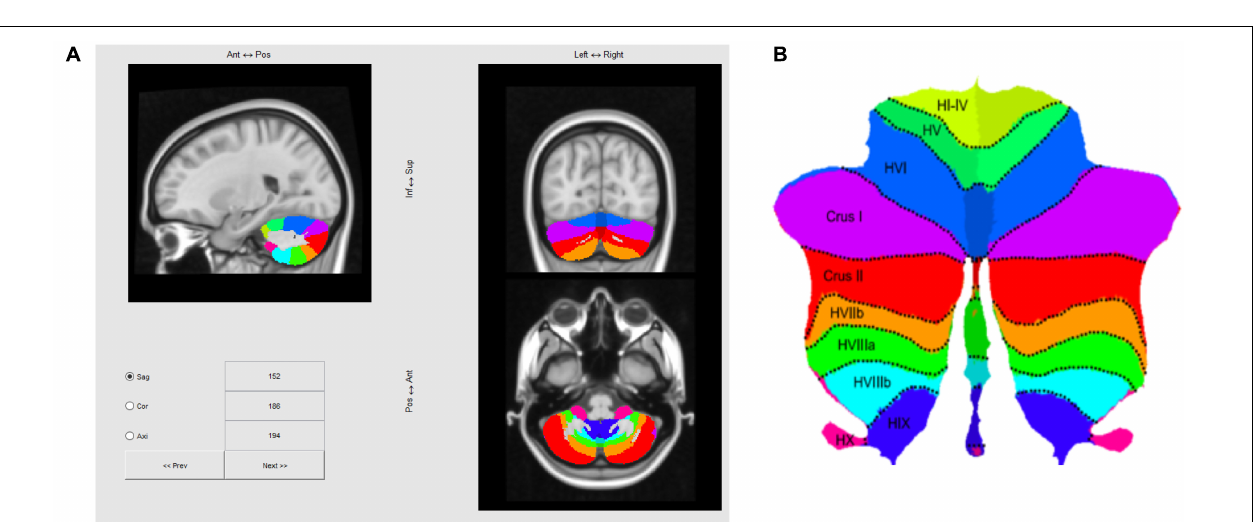
FIGURE 3 | Functional Magnetic Resonance Imaging experimental design included a sequence of two tasks (i) perceptual exploration and memorization of complex graphic material (30 s) and (ii) visualization-from-memory of these images (30 s), interleaved with fixation periods (20 s); this sequence was repeated three times for each image.